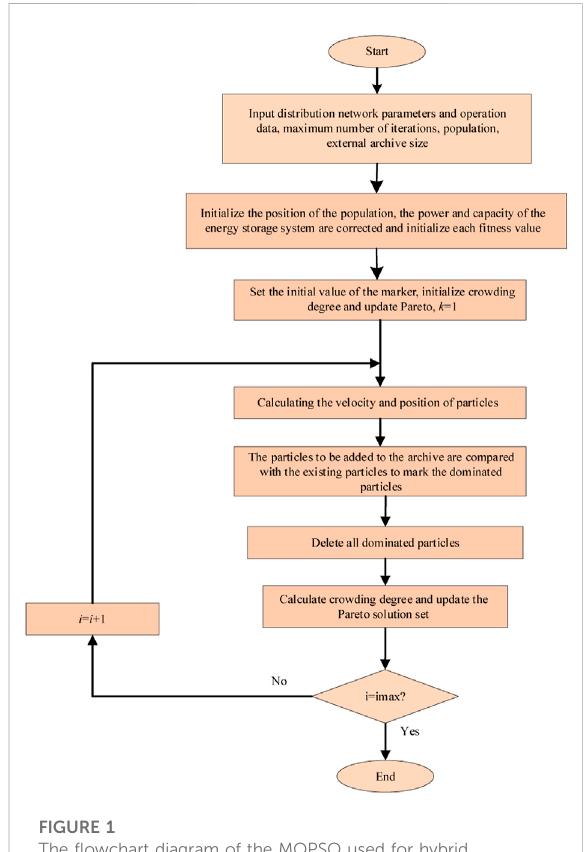
FIGURE 1 The fl owchart diagram of the MOPSO used for hybrid electric-hydrogen energy storage system.